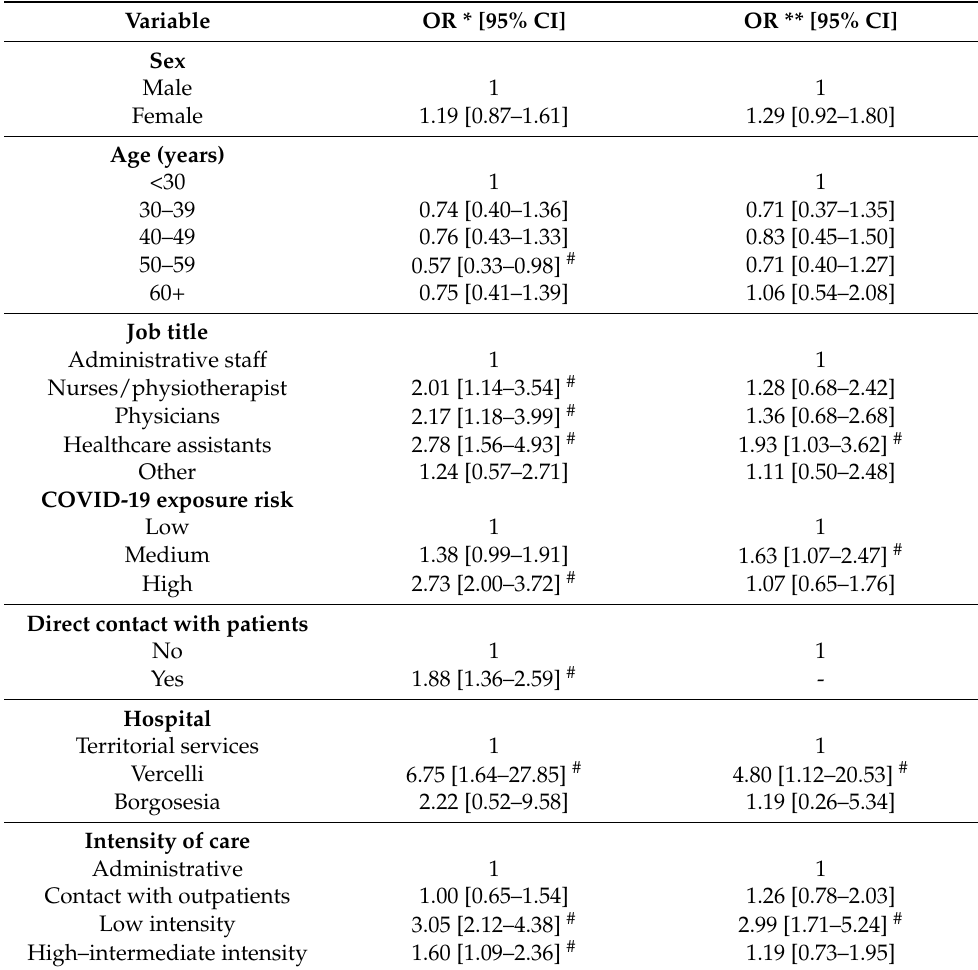
Table 3. Univariable (*) and multivariable (**) logistic models (outcome = seroprevalence). Odds ratios and 95% confidence intervals were reported. # indicates statistically significant association with p -value less than